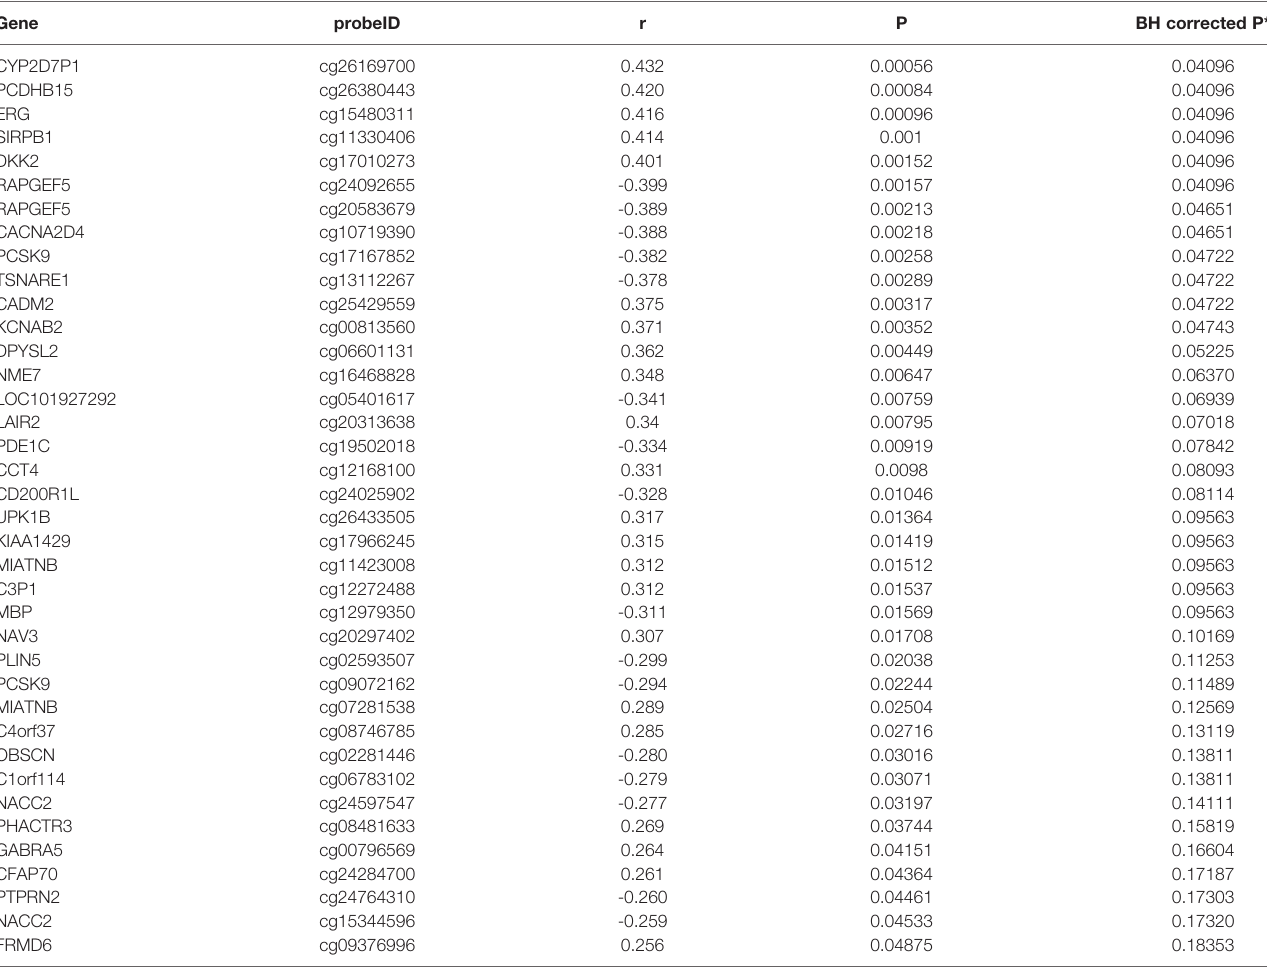
TABLE 5 | Correlations of birth weight (z score) with differentially methylated genes.